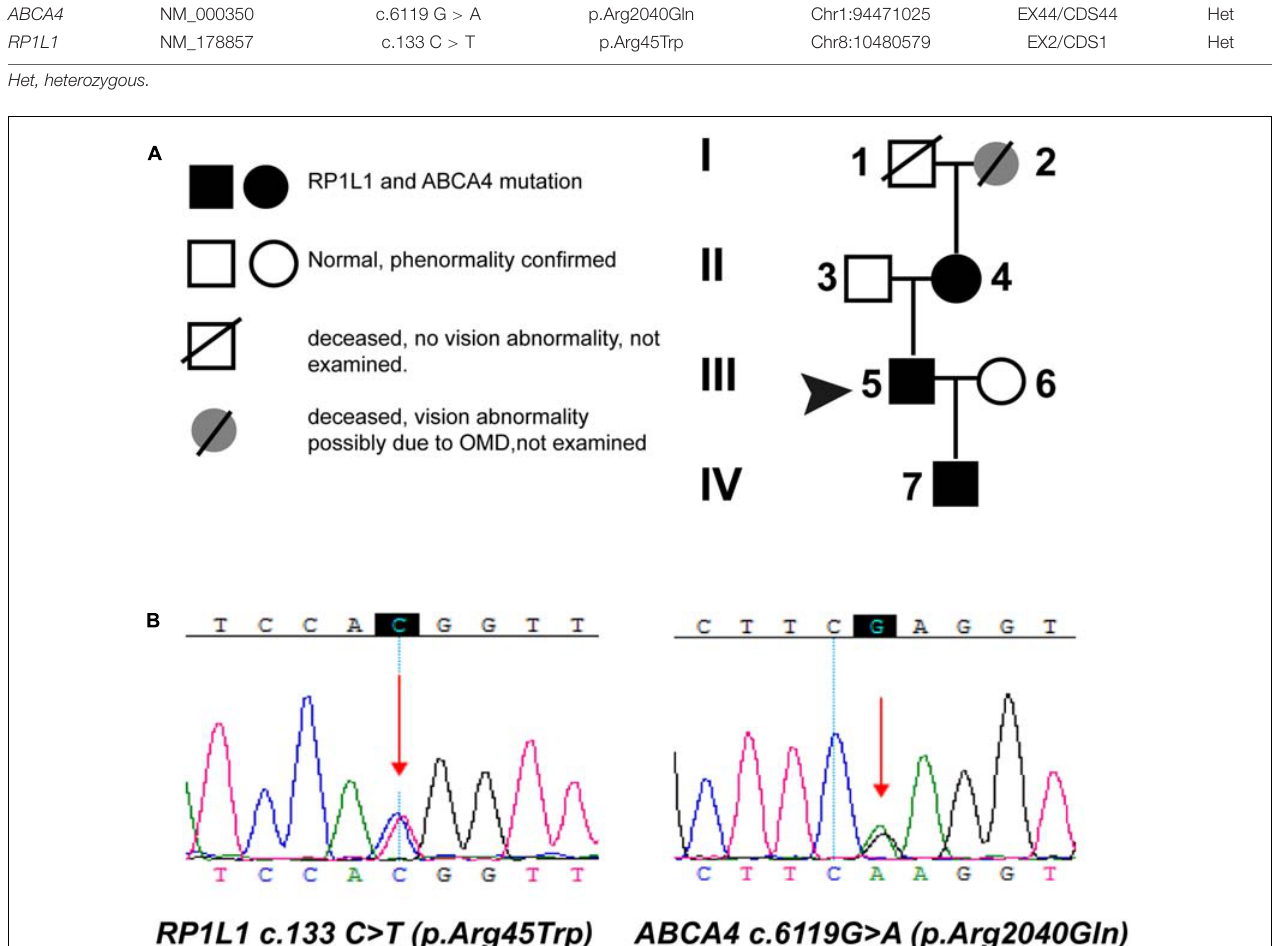
FIGURE 4 | Pedigrees (A) and identified mutations (B) . (A) Circles represent females, and squares represent males. Filled symbols represent affected patients, and empty symbols represent normal controls. (B) Sequencing results of the mutations in the ABCA4 and RP1L1 gene. Arrows indicate the position of the mutated